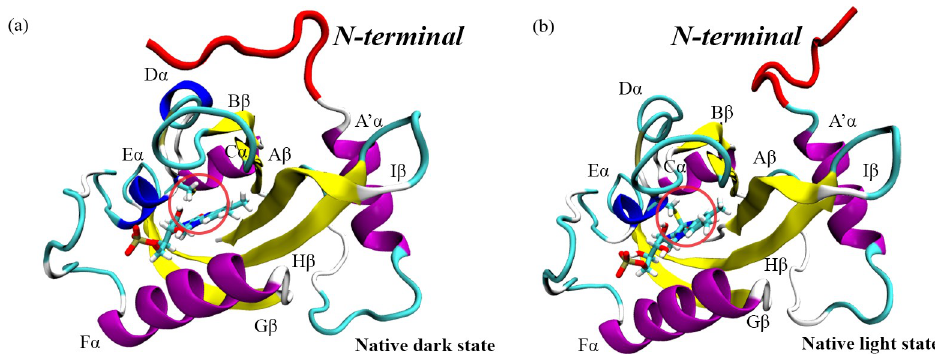
Fig 1. Two native states of VVD: (a) native dark state (PDB code: 2PD7) and (b) native light state (PDB code: 3RH8). The blue light could activate the dark state and lead to the formation of covalent bond circled in the native light state. The main conformational change lies in the N-terminal structure, which is highlighted in red.